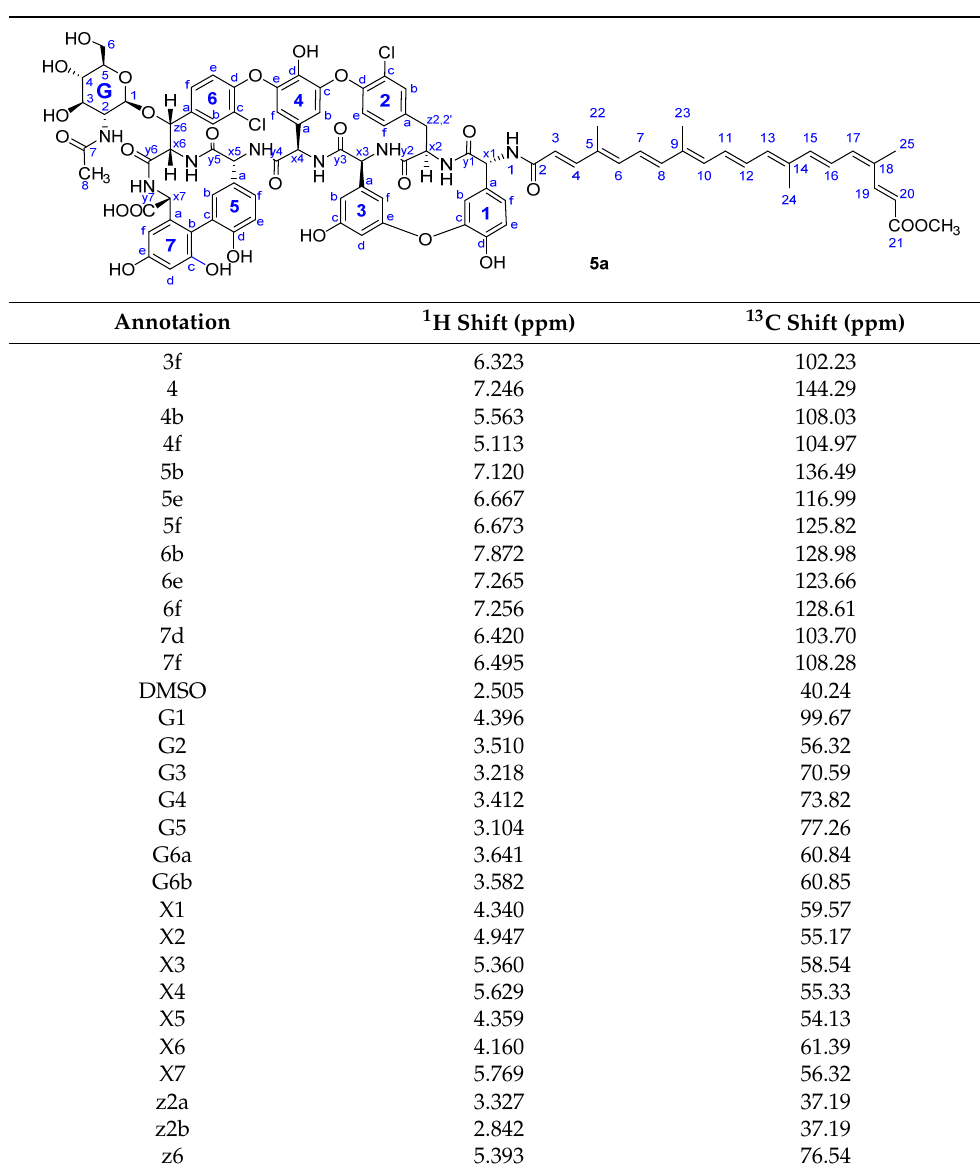
Table 4. Cont. Table 4. NMR data of 5a